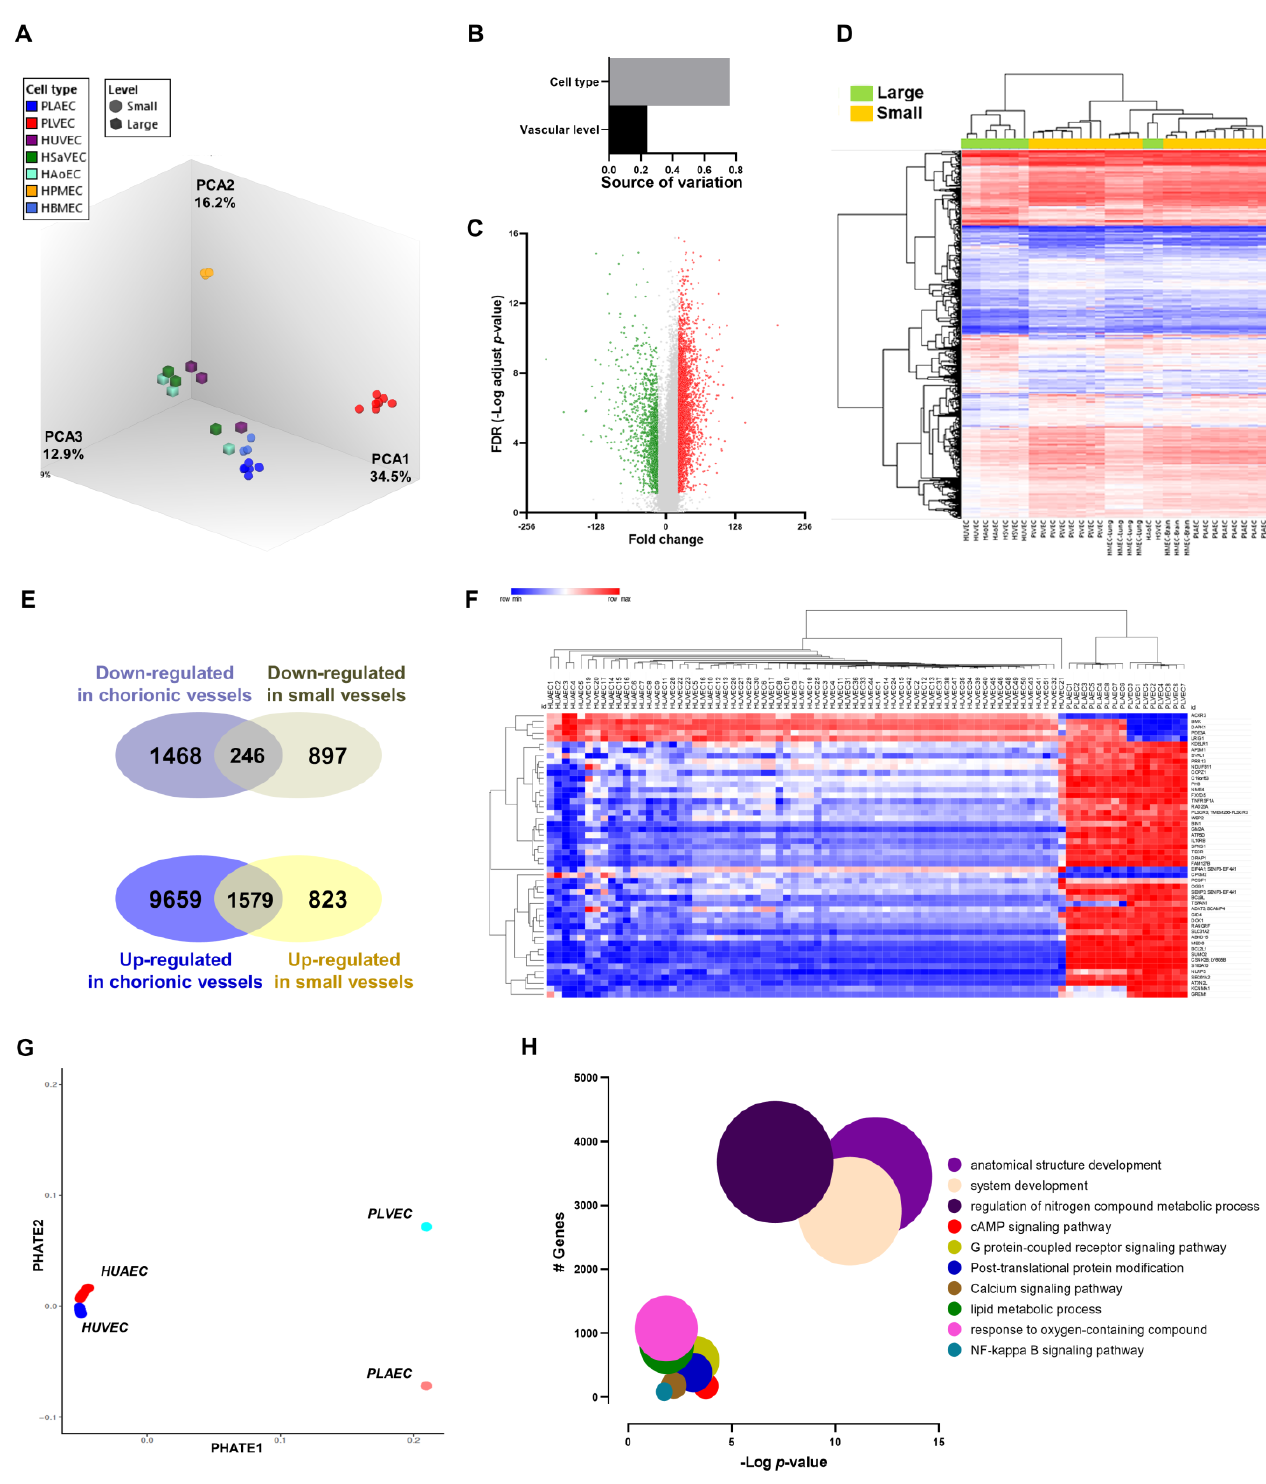
Figure 2. Transcriptional profile of macro and microvascular endothelial cells. ( A ) PCA analysis of samples distinguishing the groups by the organ of origin (color) and level (shape, circle, or square) and specifying the number of macro- ( n = 9) and microvascular samples ( n = 23) with the respective filter criteria and pie chart with upregulated (4.45%) and downregulated (9.78%) genes between samples. ( B ) Graph bar showing the contribution of cell type and vascular level origin (i.e. large or small vessels) to transcriptional variation ( C ) Volcano plot showing 1295 downregulated genes